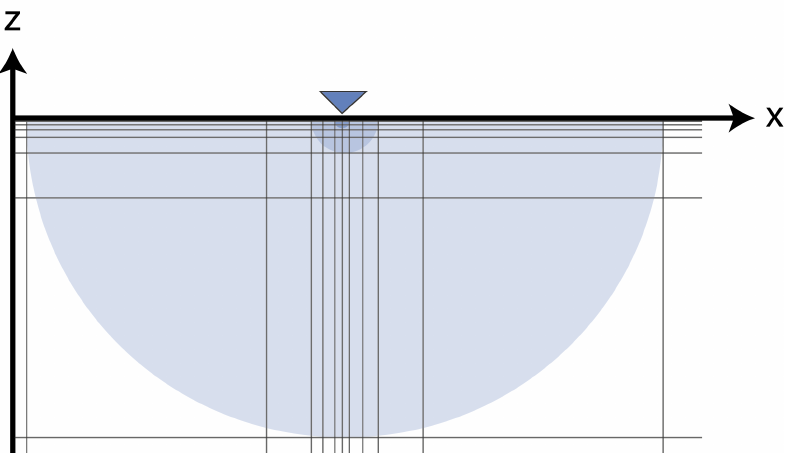
Figure 2. A 2D representation of the grid where the forward magnetics are built on. The observation point (purple) is at the center of the grid. From here, the grid spacing increases with a distance squared relationship. The magnetic field decreases cubically with distance as shown by the blue